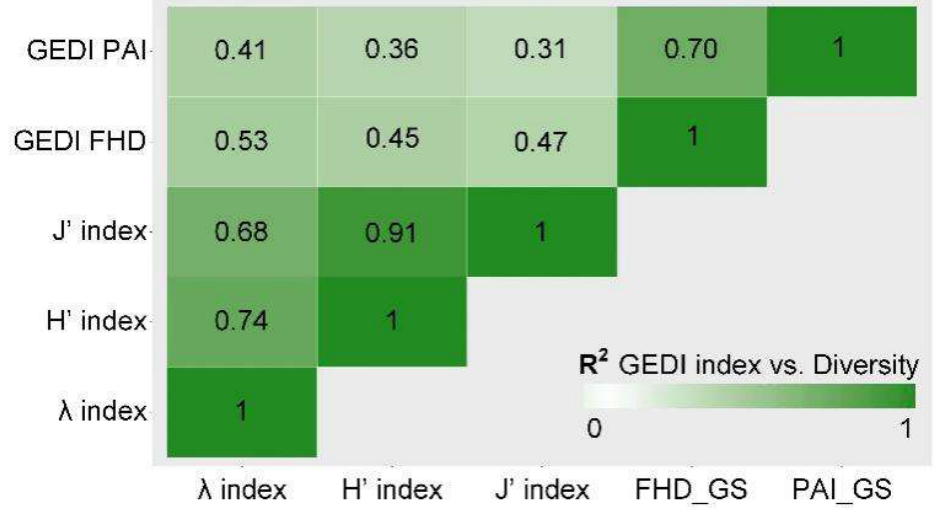
Figure 6. Coefficients of determination (R 2 ) between measured diversity indices and GEDI LiDAR indices.